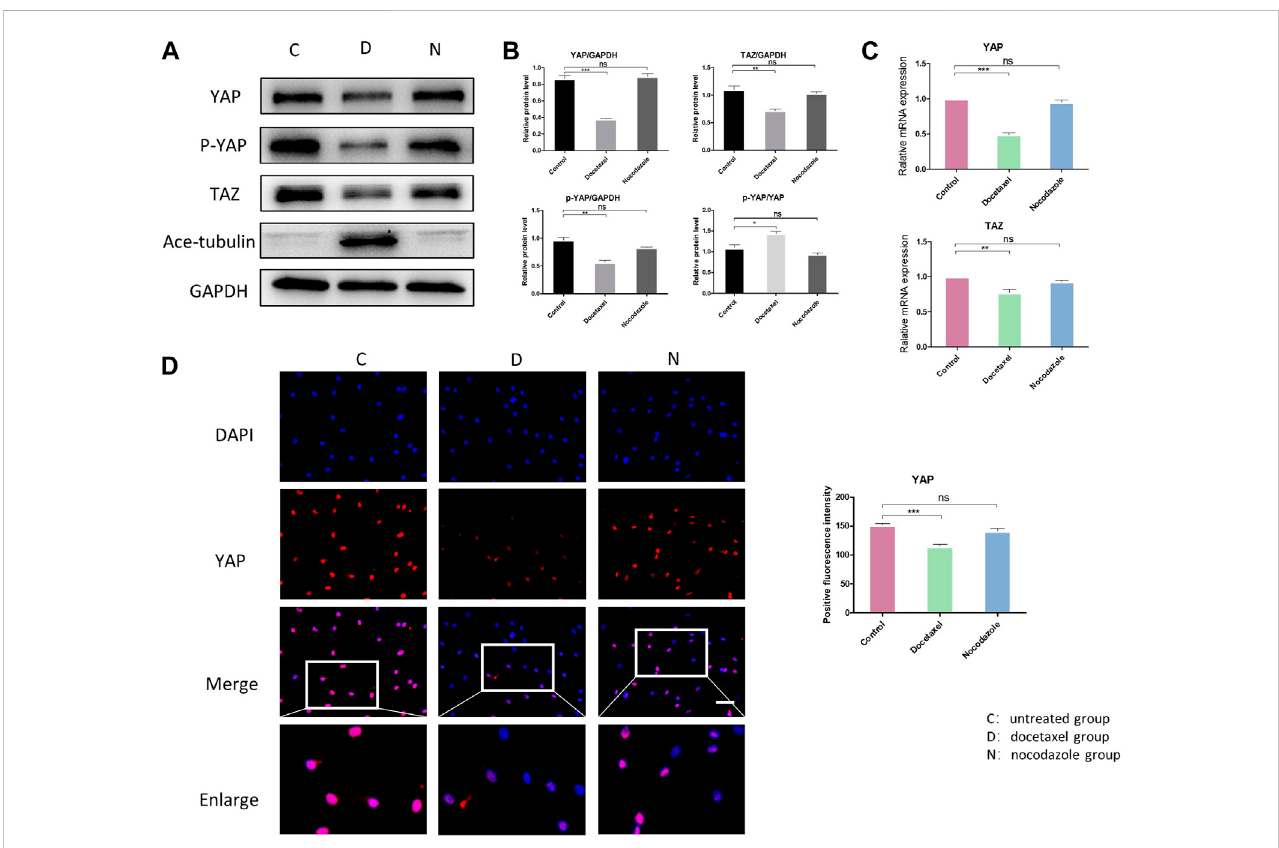
FIGURE 3 The effect of MT stabilization on YAP expression in NP cells. (A) Western blot analysis of YAP expression in NPCs treated with docetaxel and nocodazole for 1 week. (B) Quanti fi cationof thedata of (A) . n =4. (C) Q-PCR ofYAP andTAZ expression inNP cellstreated with docetaxel andnocodazole for 1 week. (D) Cellimmuno fl uorescencestainingofYAPexpressioninNPcellstreatedwithdocetaxelandnocodazolefor1 week.Scalebar,100 µm.Dataarerepresentedas the mean ± SEM. * p < 0.05, ** p < 0.01, *** p <